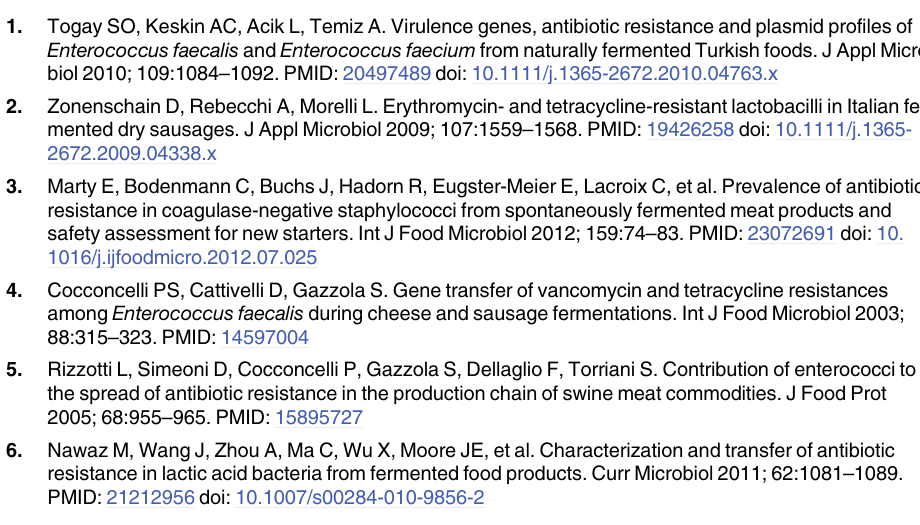
S1 Fig. Plasmid profiles of S . equorum isolates harboring the lincomycin resistance gene. Plasmids were extracted from the following strains: 1, KS1022; 2, KS1030; 3, KS3044; 4, KM1031. The ladder indicates the positions of DNA size markers. S2 Fig. Nucleotide sequence of pSELNU1. All elements involved in the double-stranded ori- gin of replication ( dso ) are blue. The single-stranded origin of replication ( sso ) region contain- ing a recombination site B sequence (RSB) and a 6-bp consensus sequence (CS-6) are shown as black boxes. Putative promoter regions of the rep and ctRNA genes are highlighted in red. The putative ctRNA stem-loop structure and inverted repeat sequences are indicated as differently colored horizontal arrows. The corresponding paired sequences are indicated with asterisks. The conserved amino acids of the Rep protein, the G, T, and HUH motifs, are shown in bold red letters. Direct repeats are highlighted in green.